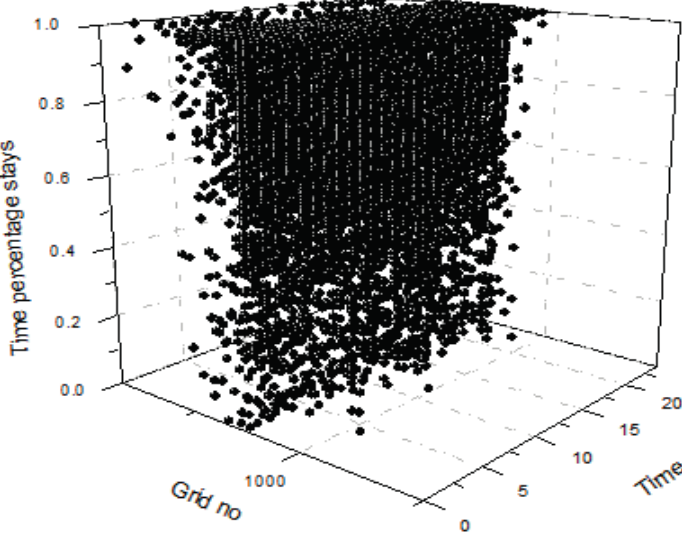
Figure 2. The tensor illustration of Geolife user